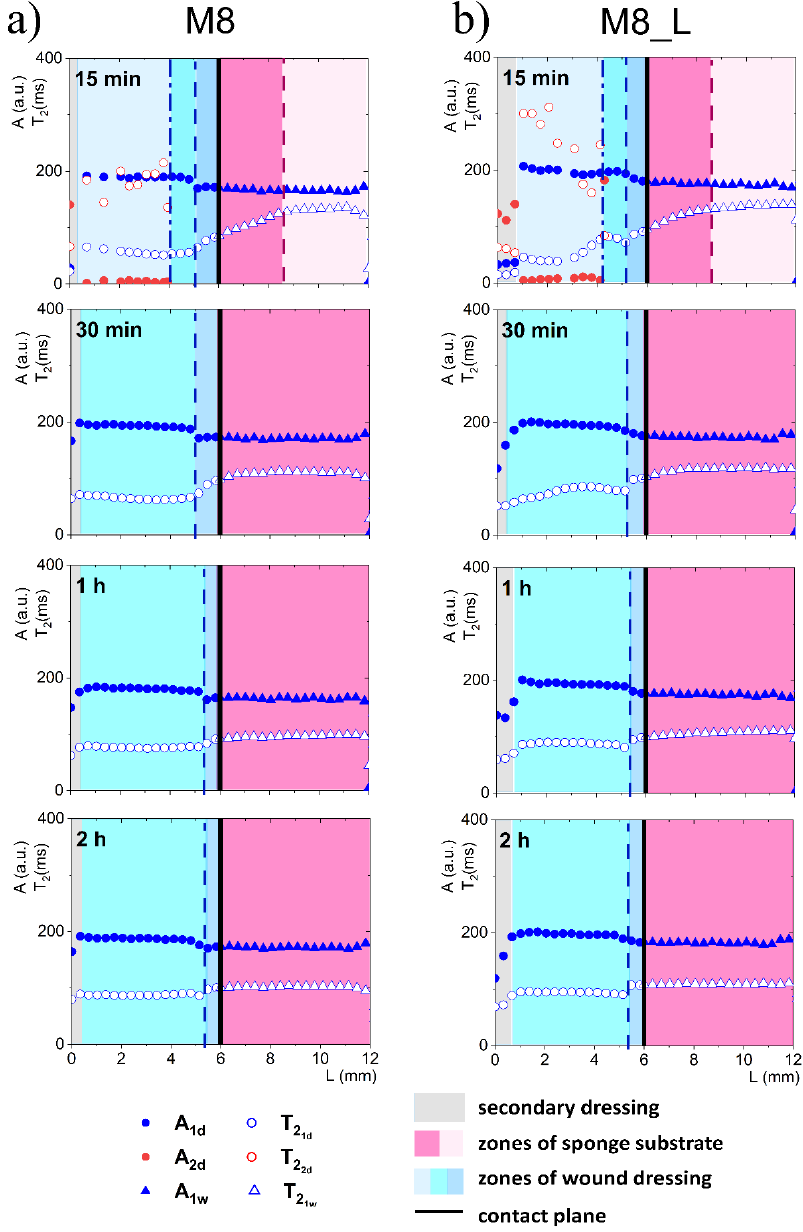
Figure 4. 1D parametric profiles in terms of relaxation time ( T 2 ) and signal amplitude ( A ) across the simulated wound dressing stack after application on sponge substrate wetted with FBS, for M8 ( a ) and M8_L ( b ).